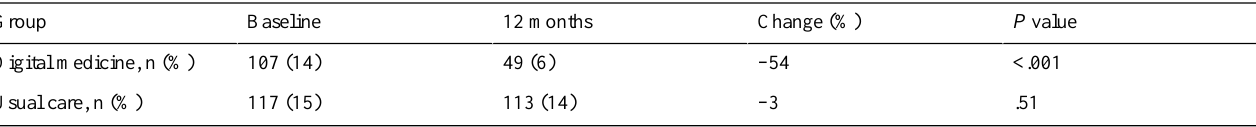
Table 4. Proportion of patients in digital medicine (n=763) and usual care (n=794) whose hemoglobin A 1c ≥ 9.0%.